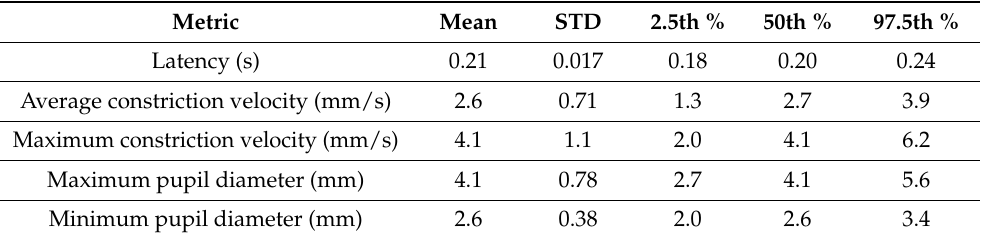
Table A2. Mean, standard deviation, and 2.5th, 50th, and 97.5th percentiles of pupillary response metrics of healthy controls.